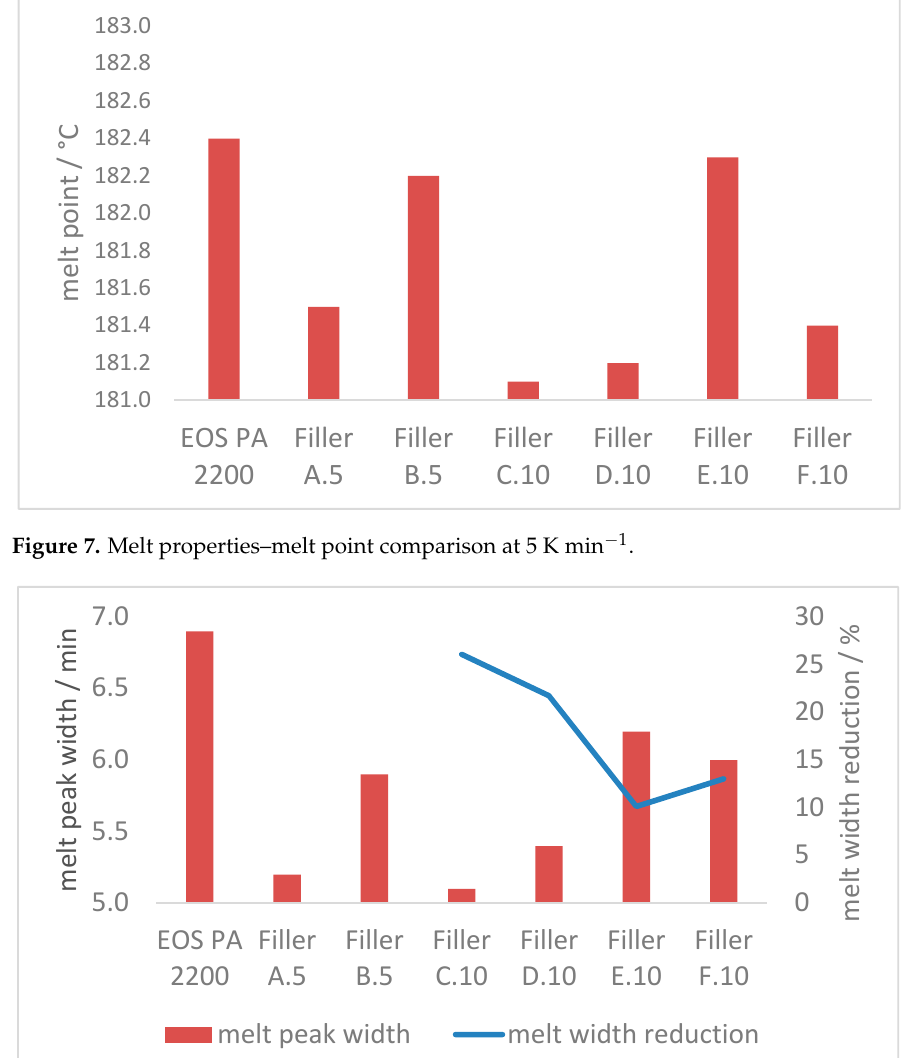
Figure 8. Melt properties–melt peak width comparison at 5 K min − 1 .